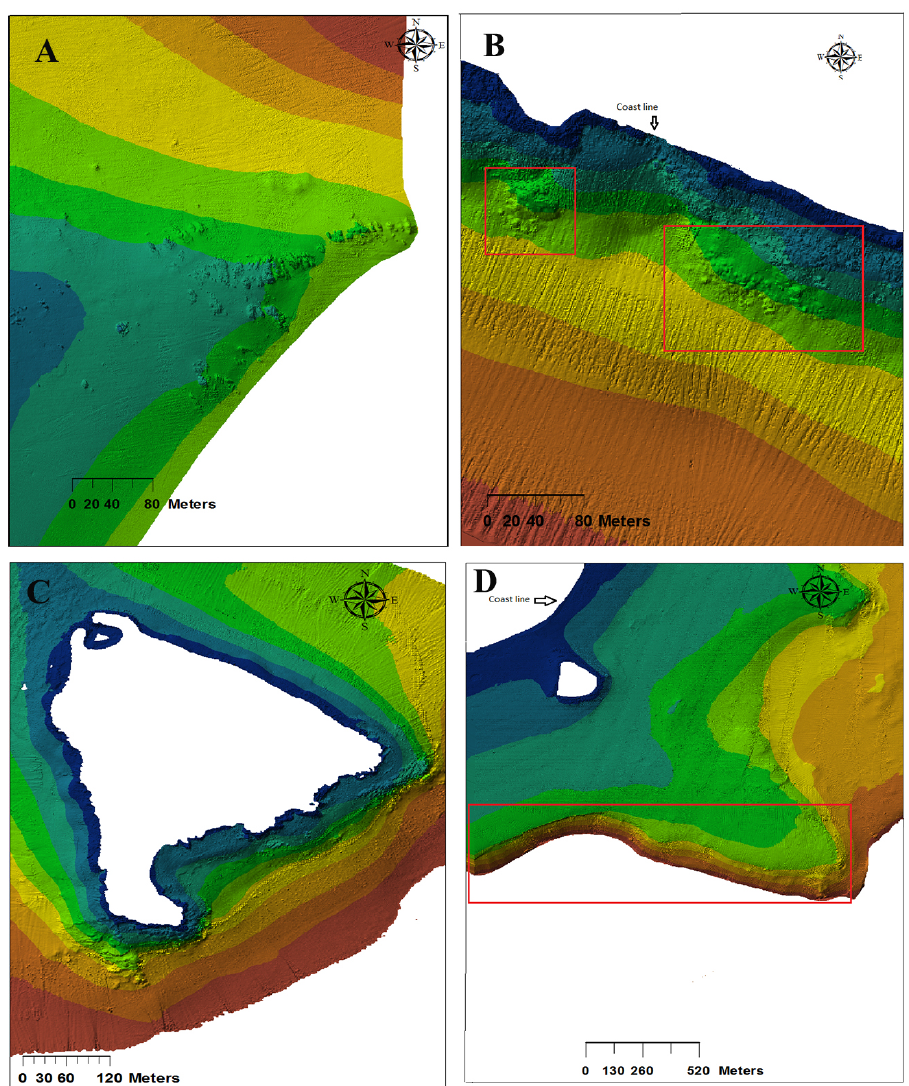
Fig. 3. – Geomorphotypes found in Liguria. A, Shoals of Vado Ligure. B, Rockfalls of Casa del Sindaco, Portofino. C, Plunging cliff of Isola Gallinara. D, Paleocliff of Secca dei Maledetti, Isola di Bergeggi. Table 3. – Distribution of coralligenous facies on the different geomorphotypes in Liguria (values in hectares). N/A, no data available. Plunging cliff Paleocliff Rockfalls Shoals Corallium rubrum 4.84 Cystoseira